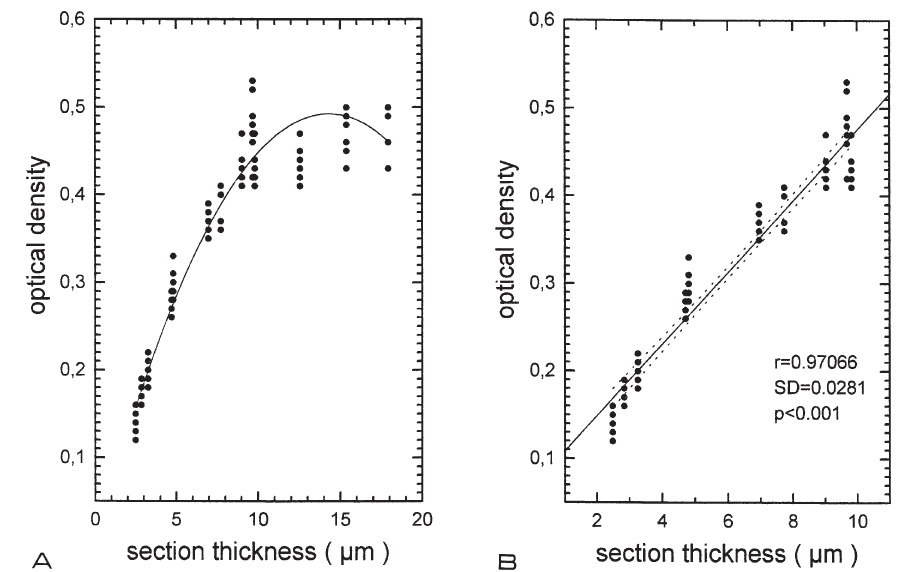
Fig. 4. (A) Optical densities plotted against actual thickness of sections taken from cylinders of the same staining batch, fitted by a parabolic curve by the “origin” software. Values beyond 10 (cid:22) m thickness deviate from linearity. (B) The same values as in (A), with exception of those greater than 10 (cid:22) m, can be adjusted to a straight line. This line can be used, for practical purposes, as a normogram to determine thickness from optical density values of the cylinders used as standards.